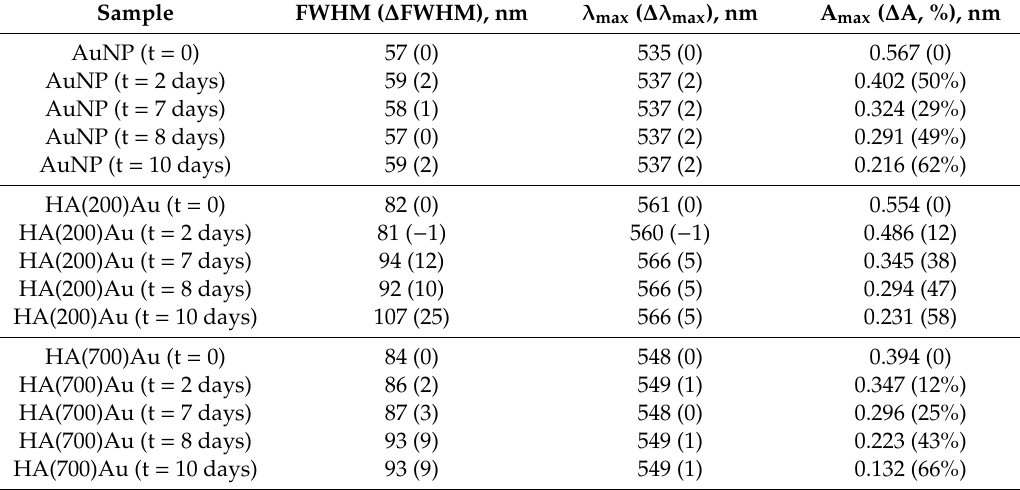
Figure 3. UV-vis spectra of AuNPs for the pellets collected after centrifugation and washing with ultrapure MilliQ water of: ( a ) as-prepared AuNPs (named ‘pellet 2’); ( b , c ) HA-conjugated NPs (named ‘pellets 3’; b: HA200, c: HA700). Each panel displays the spectra recorded at increasing aging times since the pellet resuspension up to 10 days. Table 2. Optical parameters (full width at half maximum, wavelength and absorbance at the maximum) measured from the UV-vis spectra of AuNP, bare and HA-conjugated samples for the pellets ‘2’ (bare NPs) or pellets ‘3’ (HA-conjugated NP) immediately after resuspension in ultrapure MilliQ water (t = 0) and at increasing aging times (up to t = 10 days). The di ff erence with respect to the freshly prepared pellets (t = 0) for FWHM and λ , as well as the relative percentage variation in Abs, are reported in brackets for